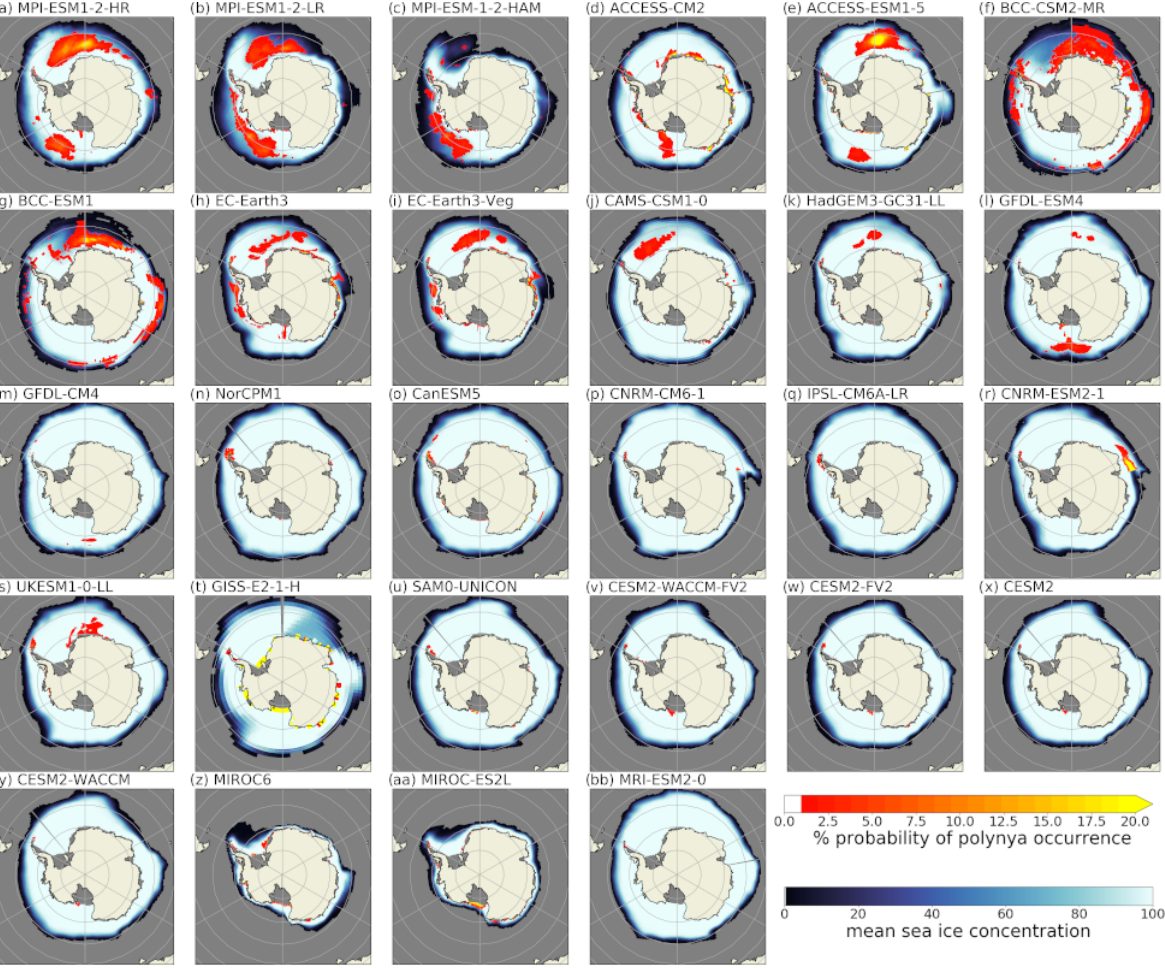
Figure A3. Spatial distribution of polynyas in the CMIP6 models, computed from the monthly sea ice concentration output for September. The red-to-yellow colours indicate the number of years where polynyas occurred within the 165 years of the historical model run for each grid cell. The blue colours show the average sea ice concentration (in